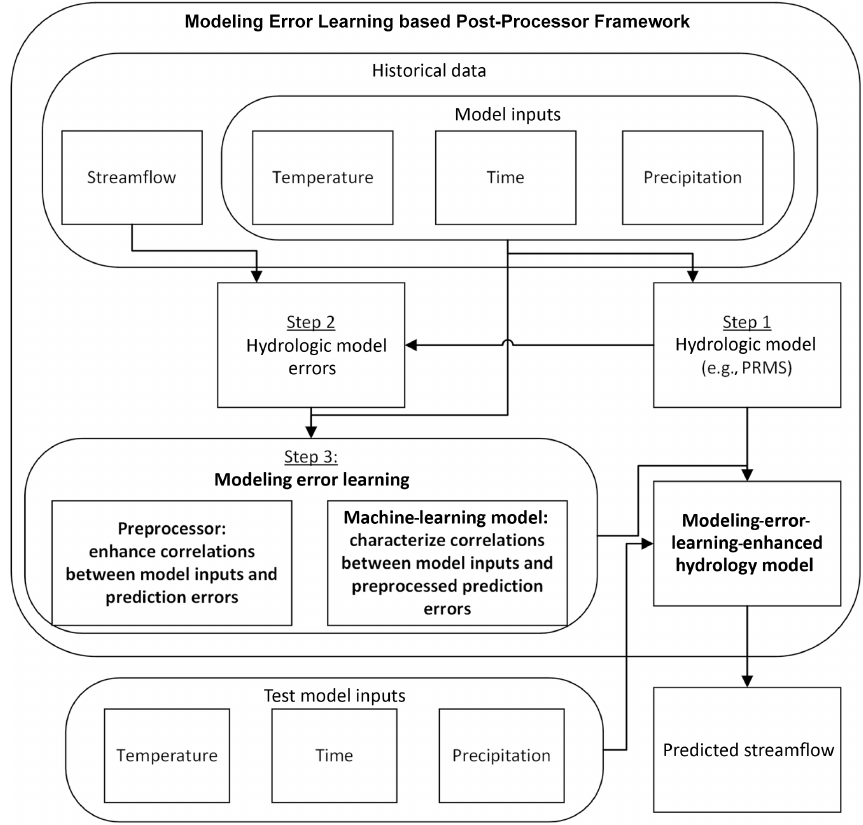
Figure 4. The diagram of the Modeling Error Learning based Post-Processor